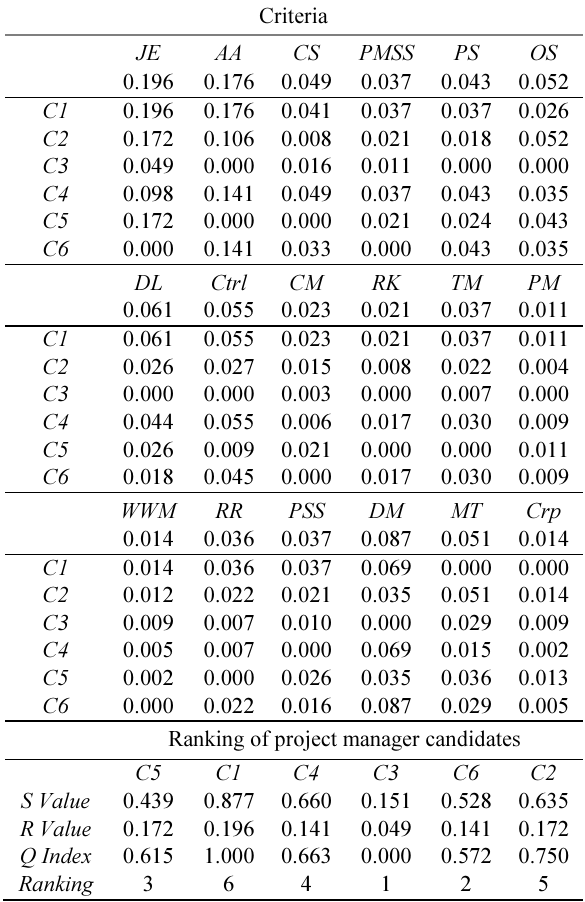
Table 9. Evaluation of alternatives with respect to criteria (integrated) and the VIKOR